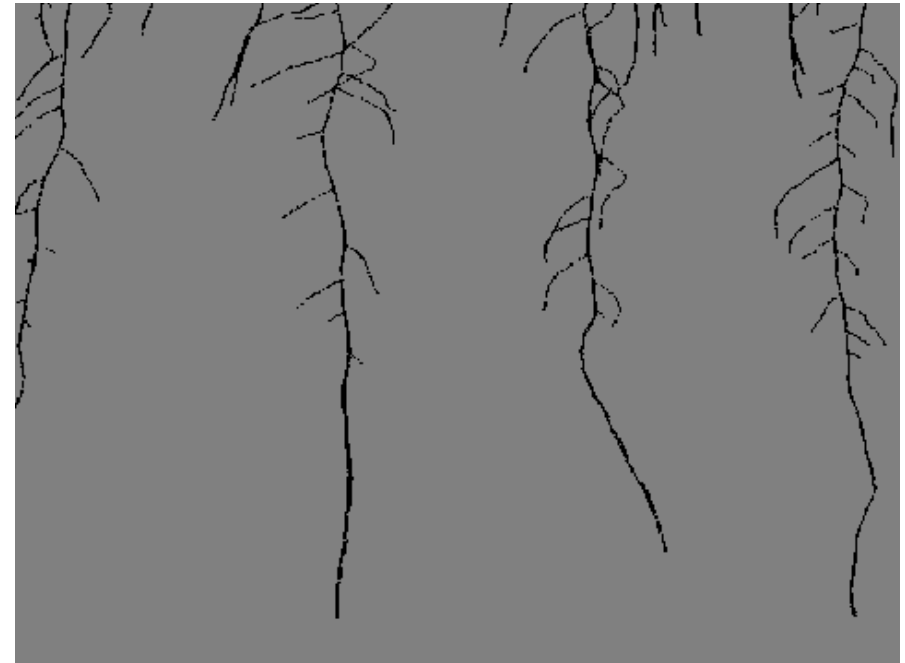
Figure 10. Corresponding annotation of Figure 9. This image is used as example to show segmenta- tion results of our trained SegNet